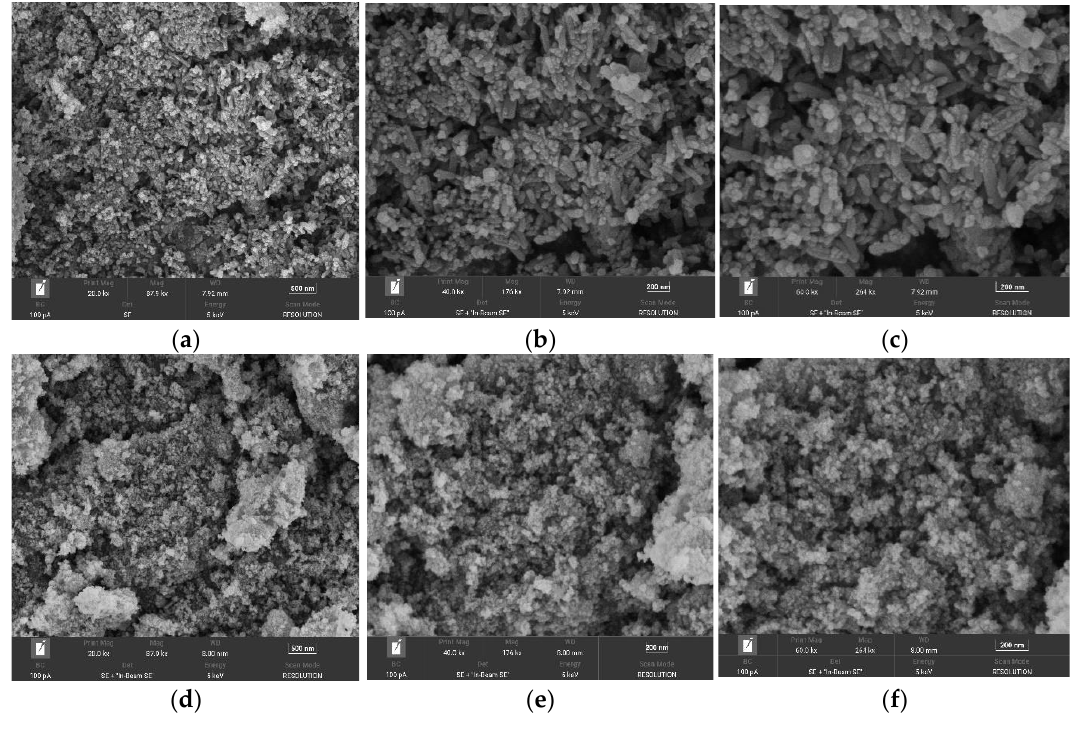
Figure 5. ( a – c ) SEM of Fe 3 O 4 @ZIF-8; ( d – f ) SEM of Fe 3 O 4.